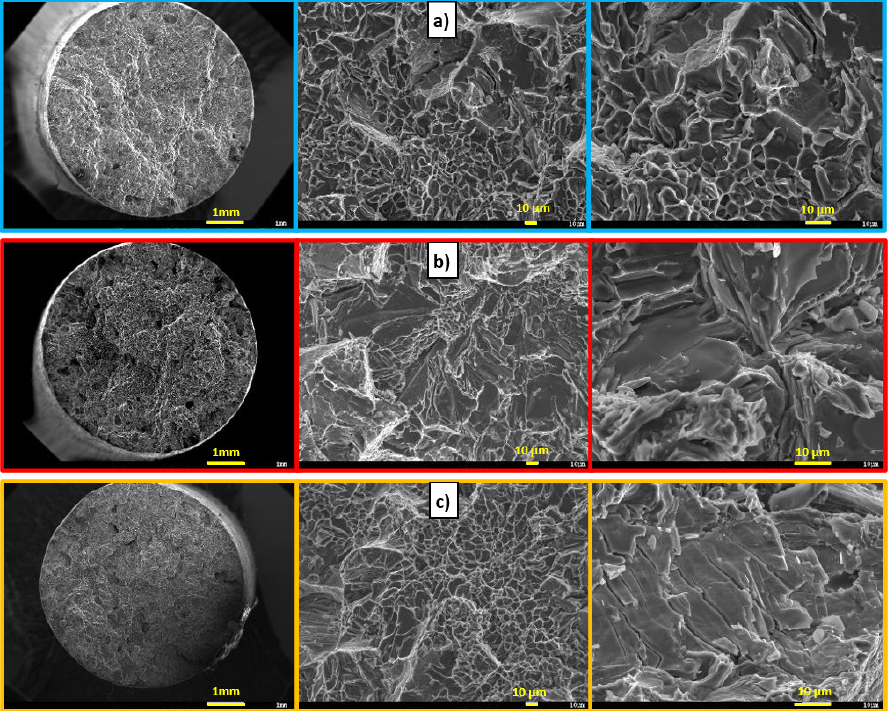
Figure 8. Macroscopic and microscopic character of fracture surfaces after heat treatment, SEM; ( a ) E1 alloy, ( b ) E2 alloy, and ( c ) E3 alloy.